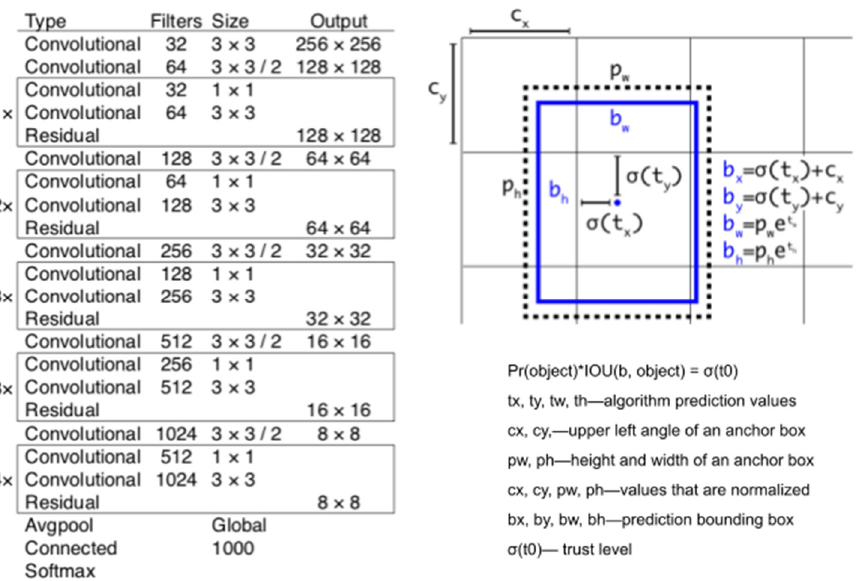
Figure 5. YOLOv3 network, DarkNet 53 and calculation of the coordinates adapted from Ref. [18]. 2018, Joseph Redmon and Ali Farhadi.